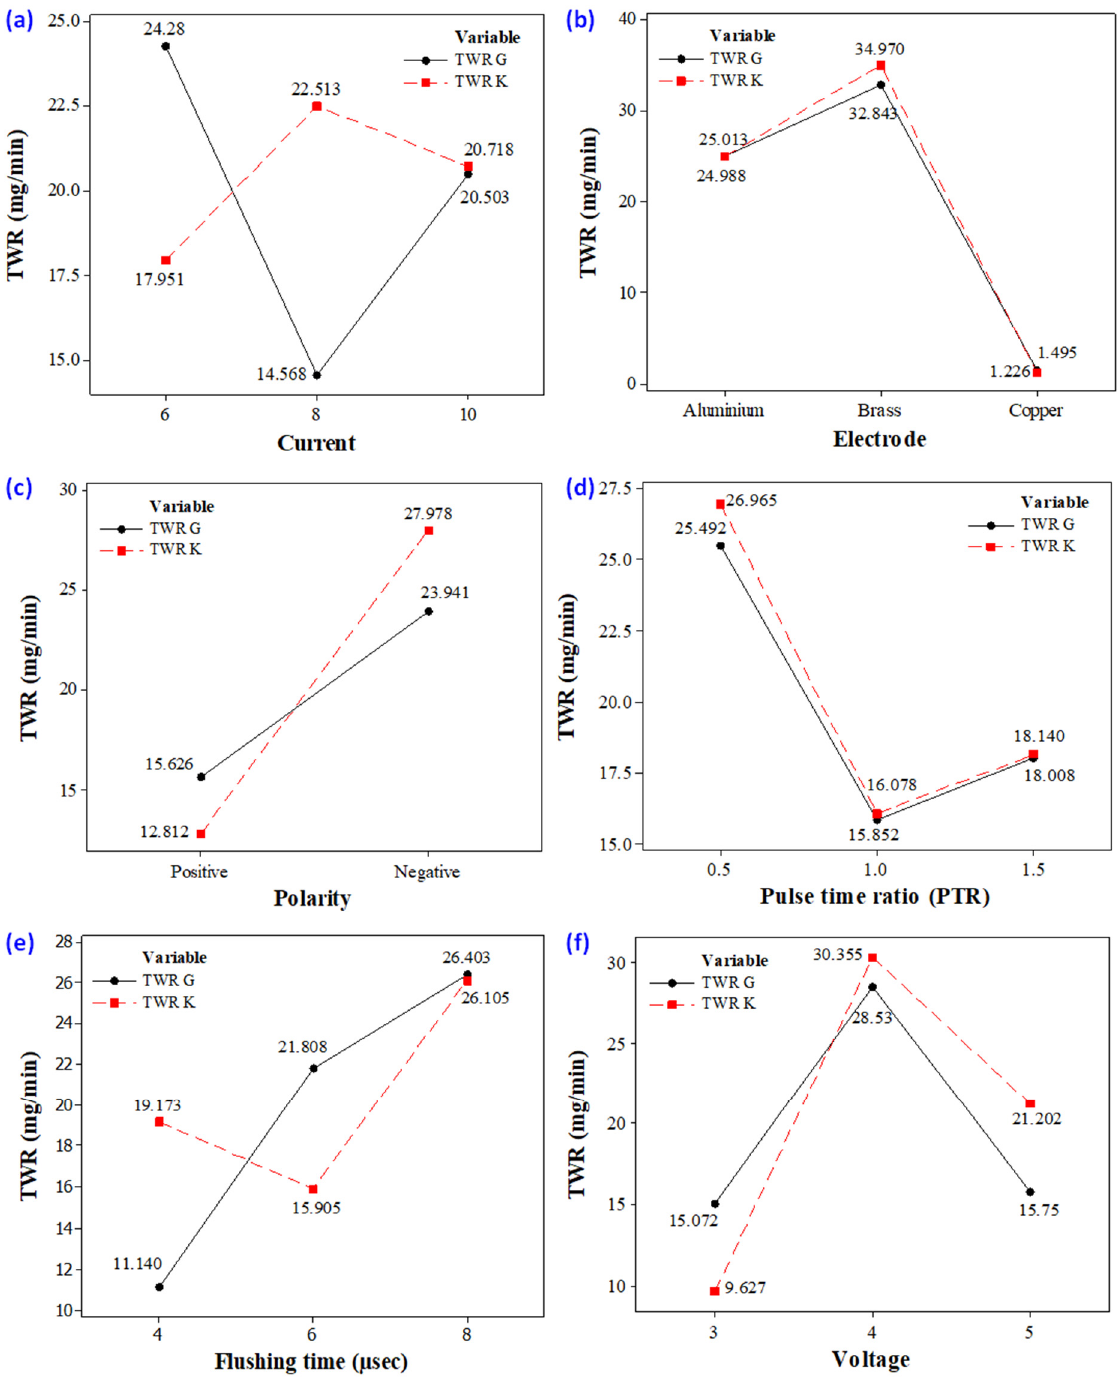
Figure 14. Parametric plots ( a ) discharge current vs. TWR ( b ) electrode vs. TWR ( c ) polarity vs. TWR ( d ) pulse–time ratio vs. TWR ( e ) flushing time vs. TWR ( f ) spark voltage vs. TWR.